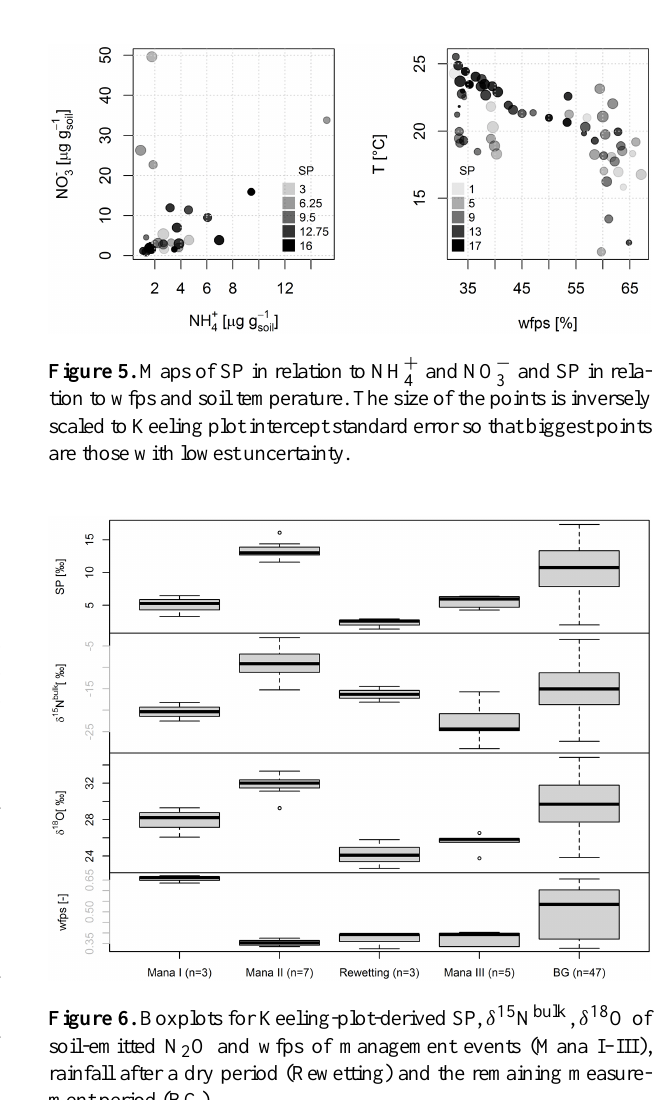
Figure 6. Boxplots for Keeling-plot-derived SP, δ 15 N bulk , δ 18 O of soil-emitted N 2 O and wfps of management events (Mana I–III), rainfall after a dry period (Rewetting) and the remaining measure- ment period